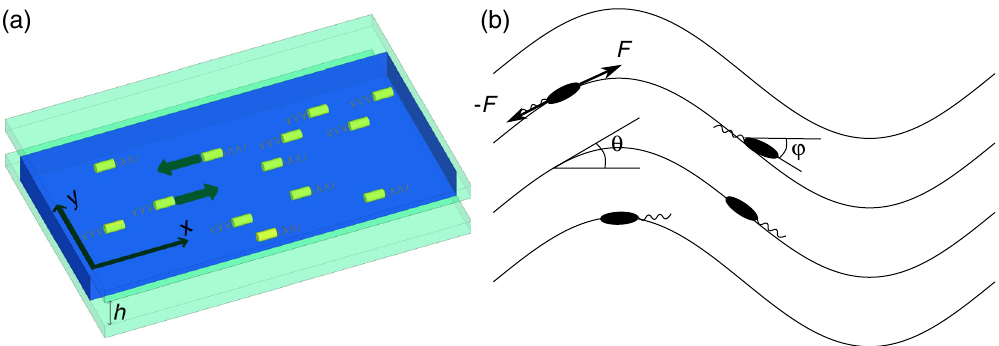
FIG. 1. Schematics of experimental cell. (a) A liquid crystal suspension of motile bacteria is sandwiched between two glass plates with the separation h [32]. A specific treatment of the glass plate inner surface anchors the LC director n along the x axis. Bacteria exhibit apolar interaction: bacteria swimming in the opposite direction can pass without collision. (b) Illustration of bacterial alignment along the LC director n . Swimming bacteria impose a pair of forces (cid:2) F (force dipole) on the